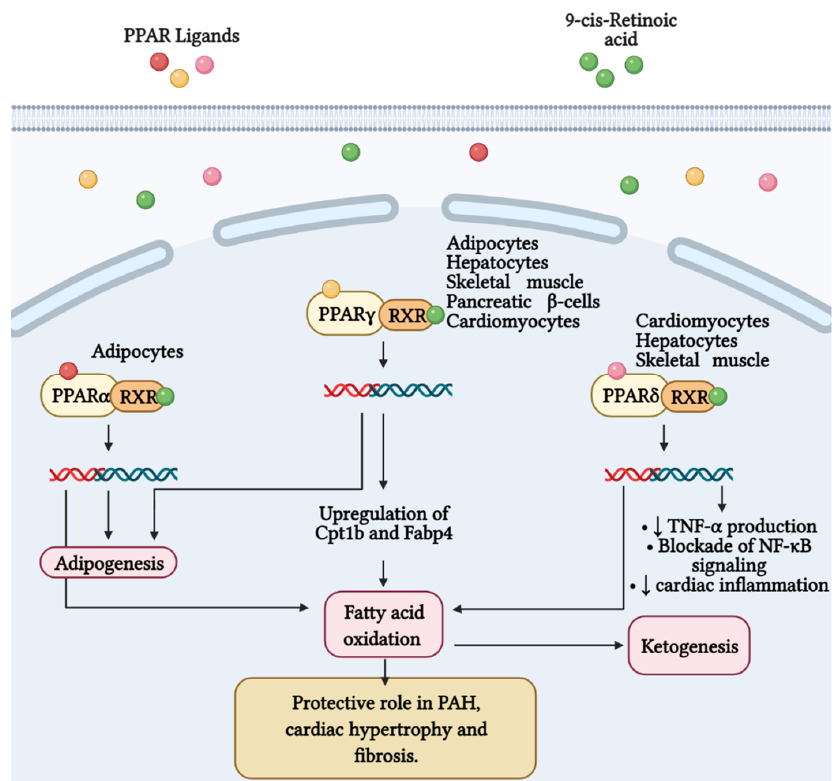
Figure 3. Fatty acid metabolism and its byproducts (ketones) play an important role in the develop- ment of right ventricular failure (RVF) and pulmonary arterial hypertension (PAH). Peroxisome proliferator-activated receptors (PPAR) belong to the superfamily of nuclear receptors that serve as ligand-activated transcription factors and consist of three members, PPARα, PPARγ, and PPARδ. These receptors together with retinoid X receptors (RXR) form heterodimers and bind to specific DNA sites to promote genetic transcription. PPARα is a master regulator of adipogenesis expressed mainly in adipose tissue and liver, as is PPARγ. Additionally, PPARγ regulates glucose and fatty acid metabolism in adipocytes, hepatocytes, skeletal muscle, and pancreatic β-cells. PPARγ ago- nists, such as pioglitazone, increase the expression of Cpt1b and Fabp4, proteins involved in fatty acid oxidation and transport in cardiomyocytes. These effects favor mitochondrial fatty acid oxida- tion and ATP production, leading to reversal of cardiac hypertrophy, fibrosis, and eliminating se- vere PAH. Furthermore, PPARδ stimulates fatty acid oxidation, decreases right ventricle hypertro- phy and pulmonary congestion. In cardiac inflammation, PPARδ blocks nuclear factor κB (NF-κB) activation and inhibits tumor necrosis factor (TNF)-α synthesis.